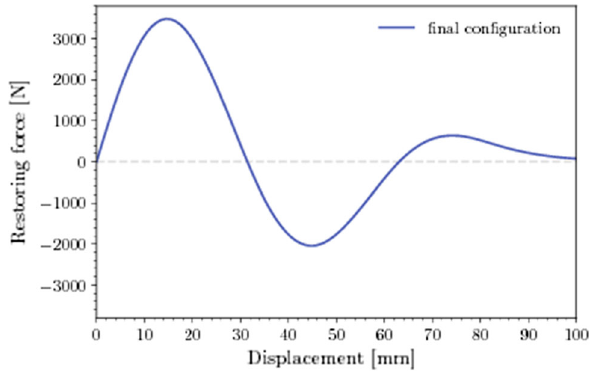
Fig. 7 Simulation of the restoring force versus ring displacement of the final pump configuration. A maximum of 3500N can be seen